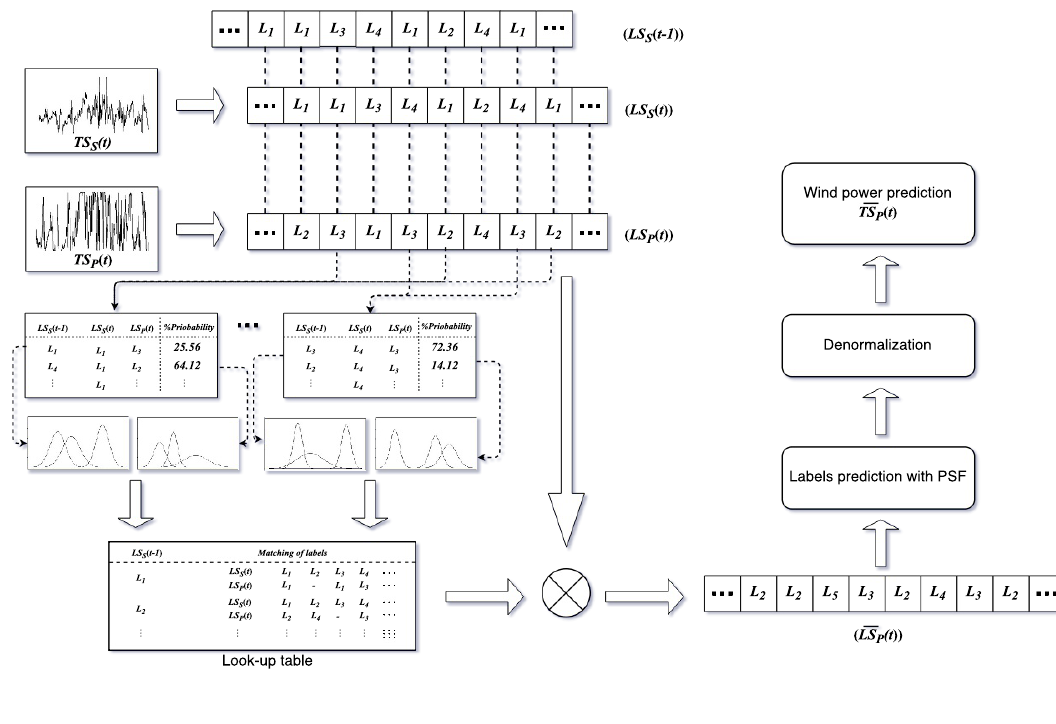
Figure 2. Steps involved in the proposed methodology.